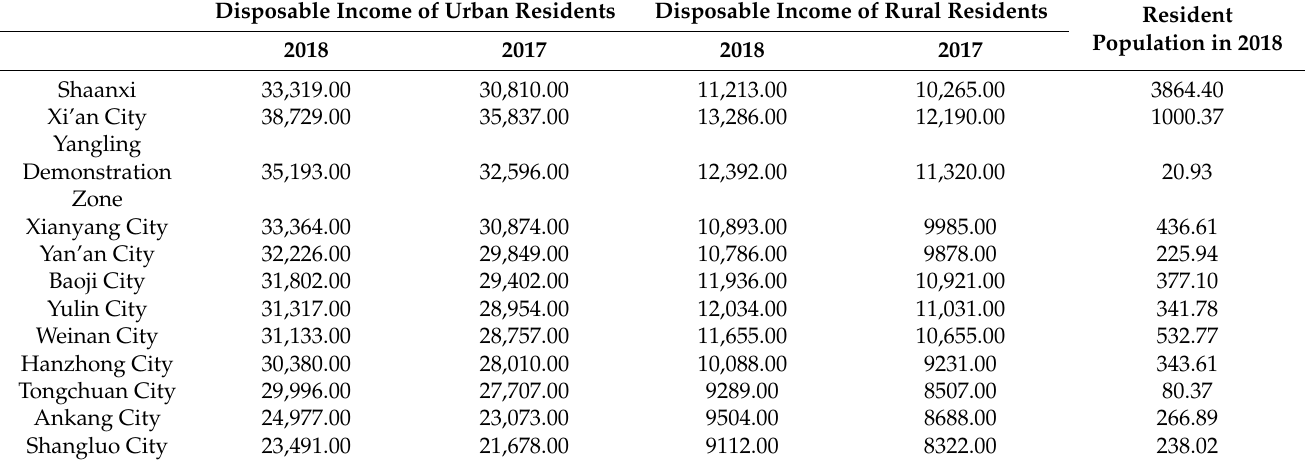
Table 2. Disposable income of residents and number of residents living in cities and districts in